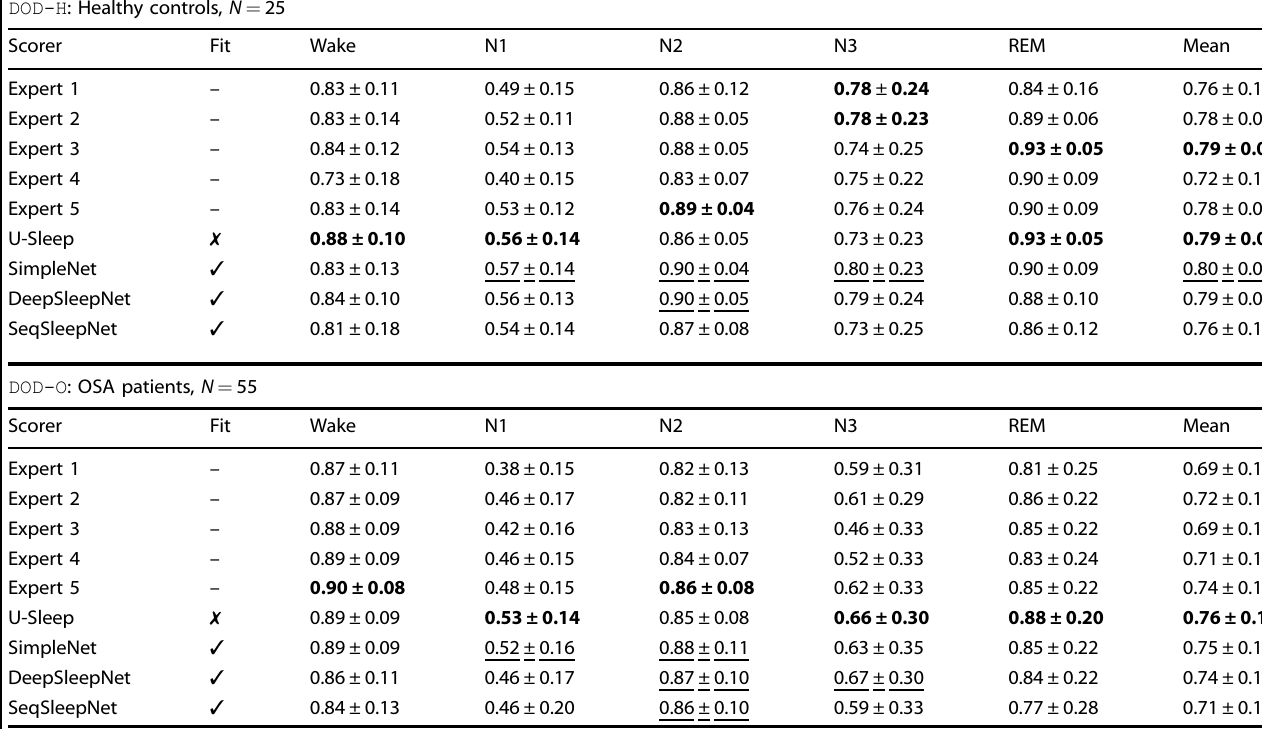
Highest scores from human experts and U-Sleep are highlighted in bold. Scores where one of the trained ML models (last three rows) performed as well or superior to U-Sleep are indicated by underlined numbers. However, these models were fi t to the particular datasets, while U-Sleep has not seen any data from DOD-H and DOD-O during model building and training, indicated by checkmarks or crosses in the Fit column. Numbers shown are mean ±1 standard deviation per-subject F1 scores computed between the output of a single model or human expert and the consensus scores generated from the 4 (N − 1) remaining (when comparing human to consensus) or best human annotators (when comparing model to